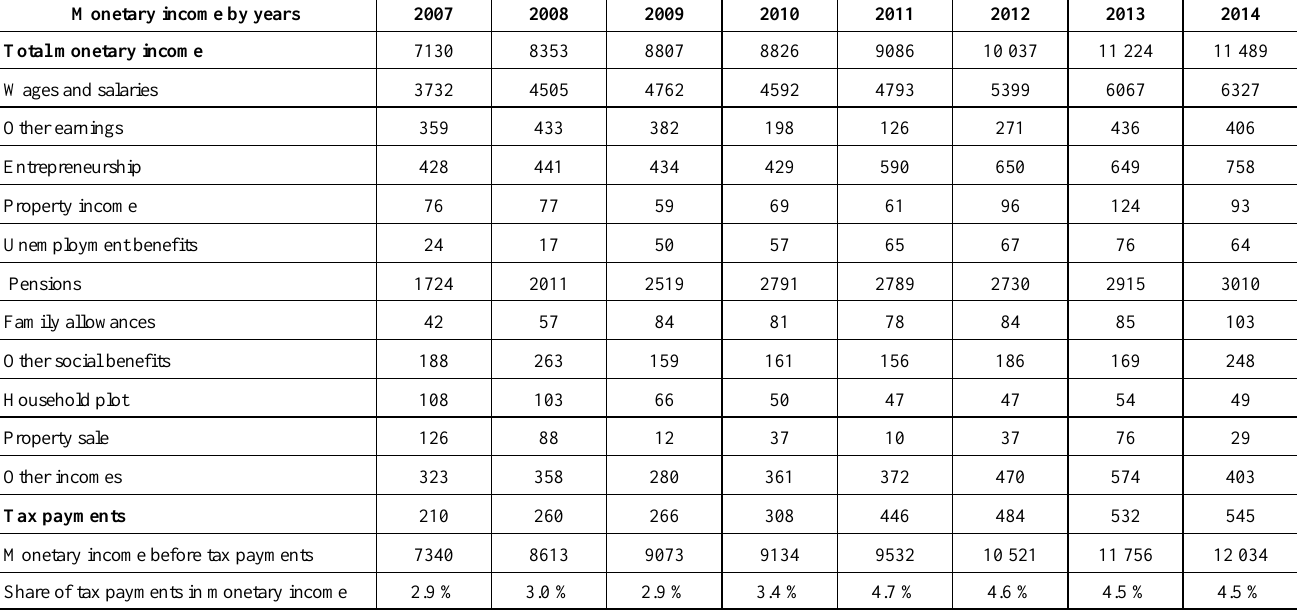
M ONETARY I NCOME AND T AX E XPENDITURE OF H OUSEHOLDS IN THE R EPUBLIC OF B ULGARIA (A VERAGE V ALUES